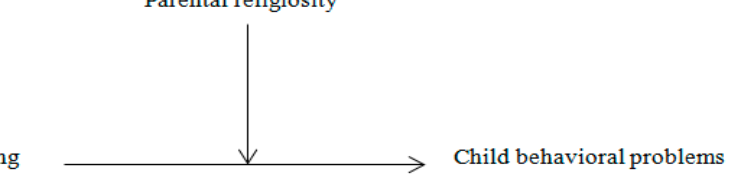
Figure 1. The moderating role of maternal religiosity in the relations between harsh physical parenting and child behavioral problems.